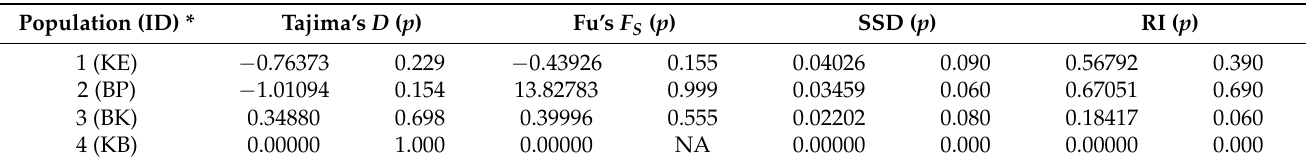
Table 5. Tajima’s D , Fu’s Fs neutrality tests, Sum of Squares Deviation (SSD) and Raggedness Index (RI) with related p